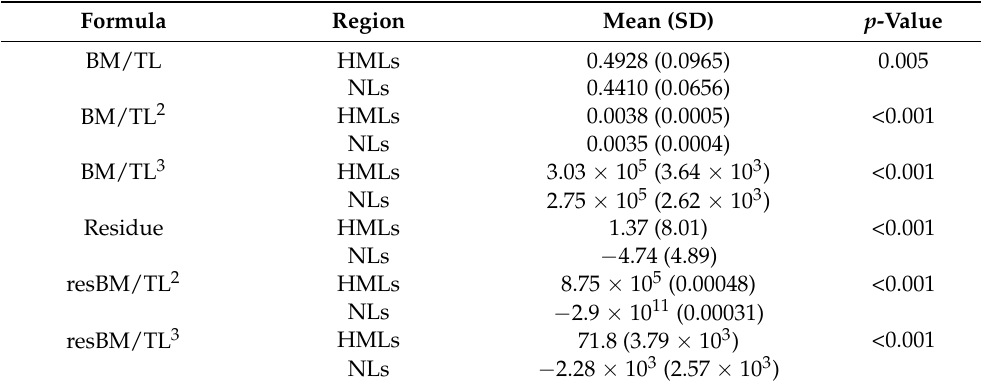
Table 4. Body Condition Index average values of capybaras from human-modified landscapes (HMLs) and natural landscapes (NLs).